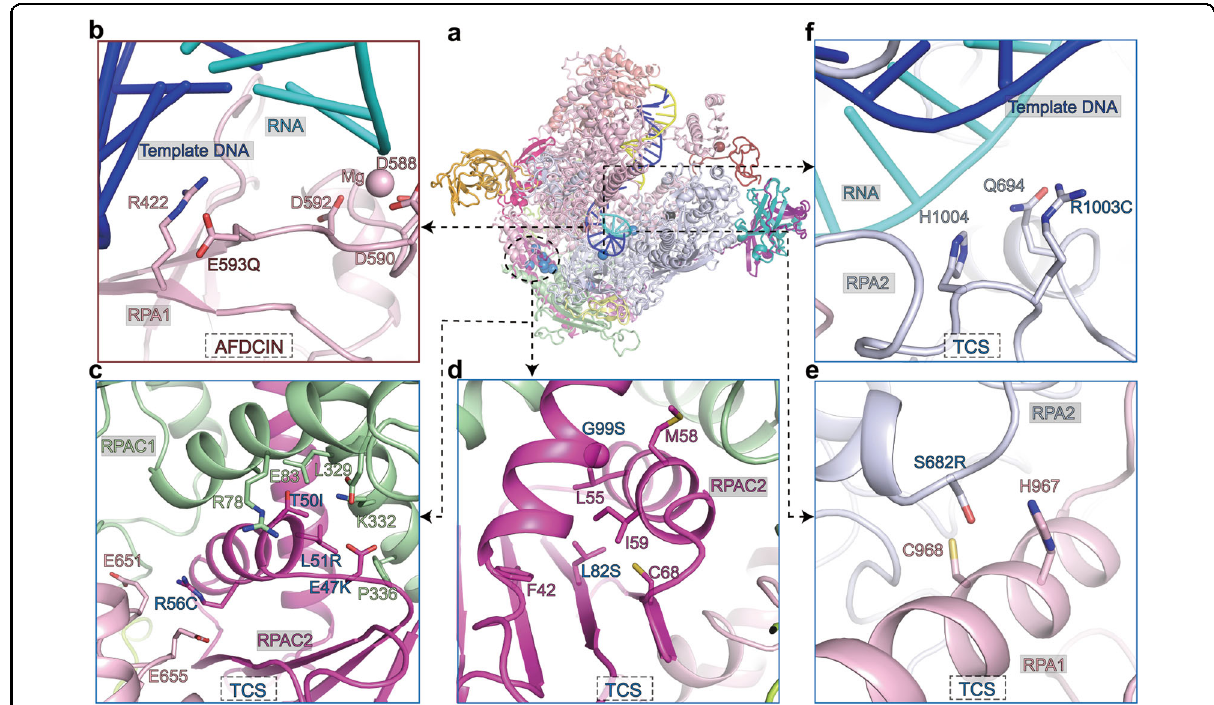
Fig. 5 Disease-associated mutations in hPol I. a Overall structure of the hPol I EC post with spheres indicating the positions of mutations associated with AFDCIN (red), neurodegenerative diseases (black), and TCS (blue). b – f Close-up views of the positions of disease-associated mutations. Mutant residues and potential contacting residues are shown in